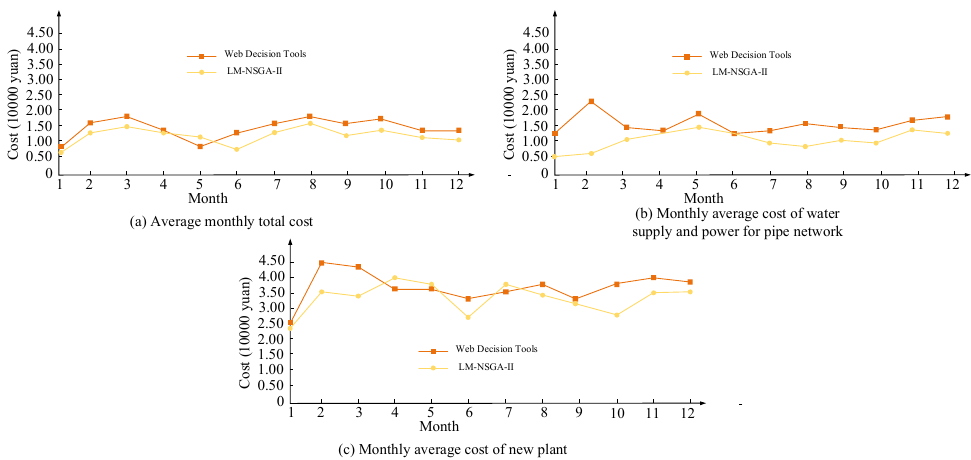
Figure 8. Comparison of optimization results between traditional methods and intelligent algorithms.